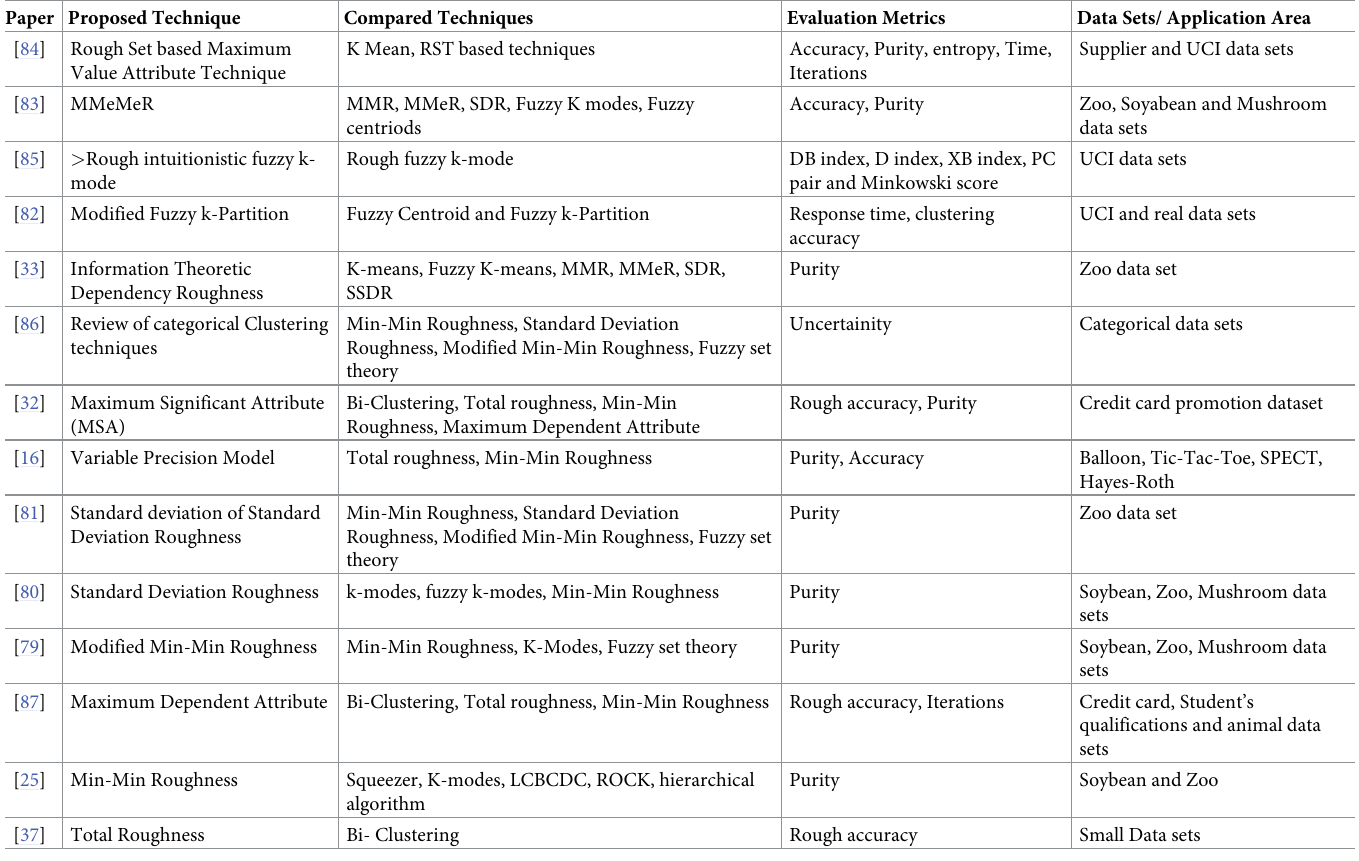
Table 3. Summary of existing work on rough categorical data